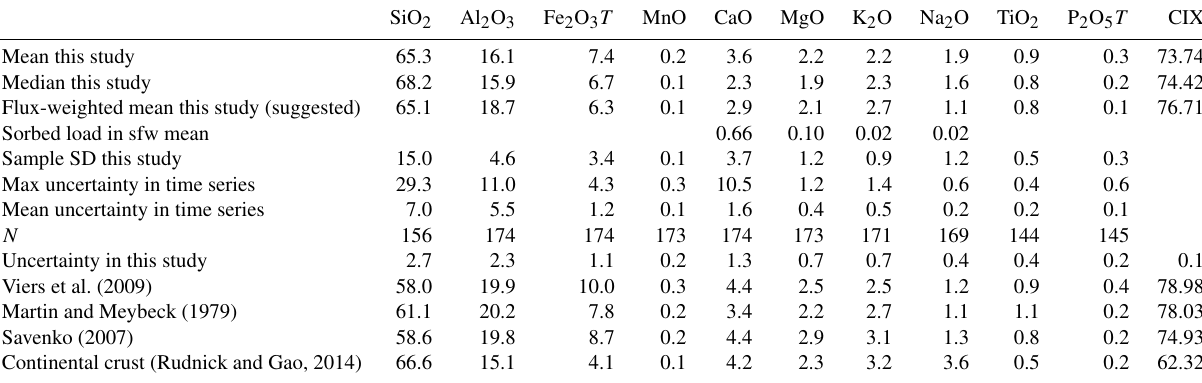
Table 1. Global average major element composition of riverine suspended matter discharged to the ocean in weight % relative to total suspended matter and normalized to 100% excluding organic matter and oxides often lost during preparation (e.g. CO 2 and H 2 O). The mean, median and sediment-flux-weighted average of this study are compared to previous estimates from the literature. T denotes the total concentration of ferric + ferrous Fe or organic + inorganic P, respectively. CIX is a chemical alteration index calculated on a molar basis (Garzanti et al., 2014; Eq. 1). The error estimate belongs to the flux-weighted mean and does account for sampling-time-induced uncertainty and sample standard deviation and number of samples ( N ). Sorbed load was calculated based on published CEC, Al / Si ratios, and mean fraction of Ca, Mg, Na and K in the sorbed pool (Tipper et al.,